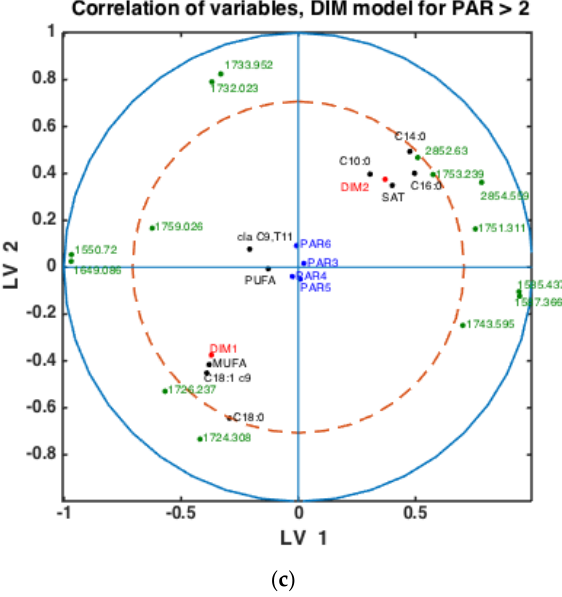
Figure 5. Correlation loading plots obtained from SPLSDA models for classification of FTIR spectra into the two main groups of DIM: DIM1: DIM ≤ 50; DIM2: 50 < DIM < 100. Models obtained using samples of groups PAR1 in ( a ), PAR2 in ( b ) and PAR > 2 in ( c ) are used to generate the correlation plots.